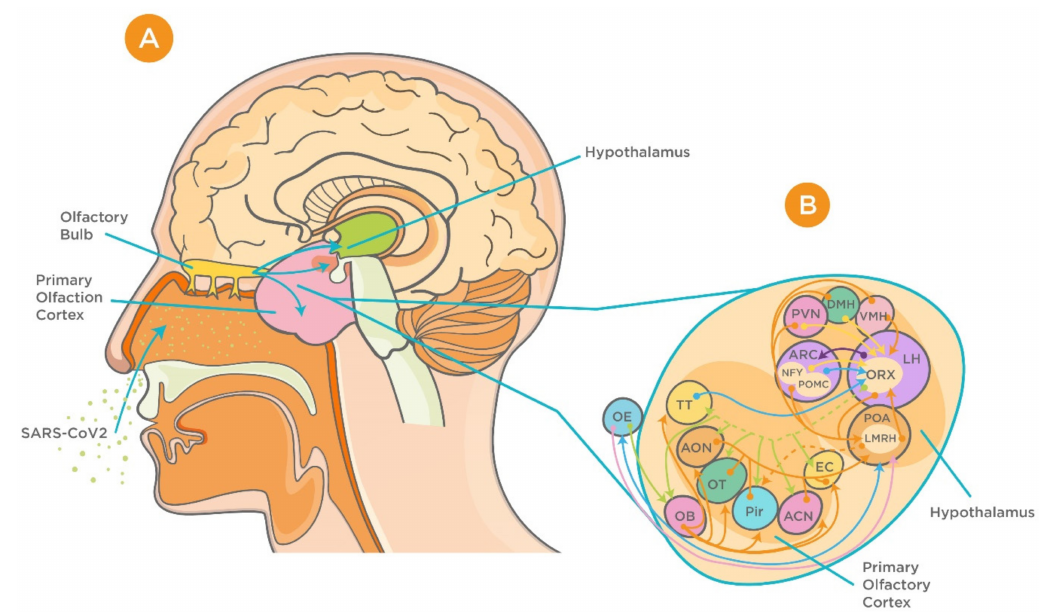
Figure 2. Proposed neuroinvasion of severe acute respiratory syndrome coronavirus 2 (SARS-CoV-2) and